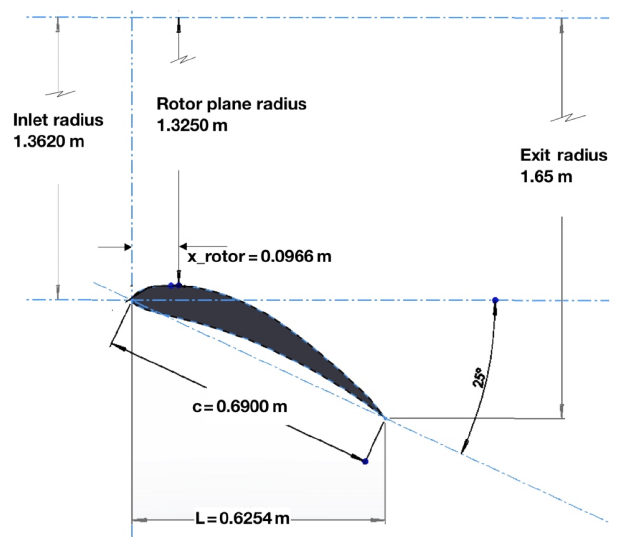
Figure 11. University of Waterloo wind turbine test